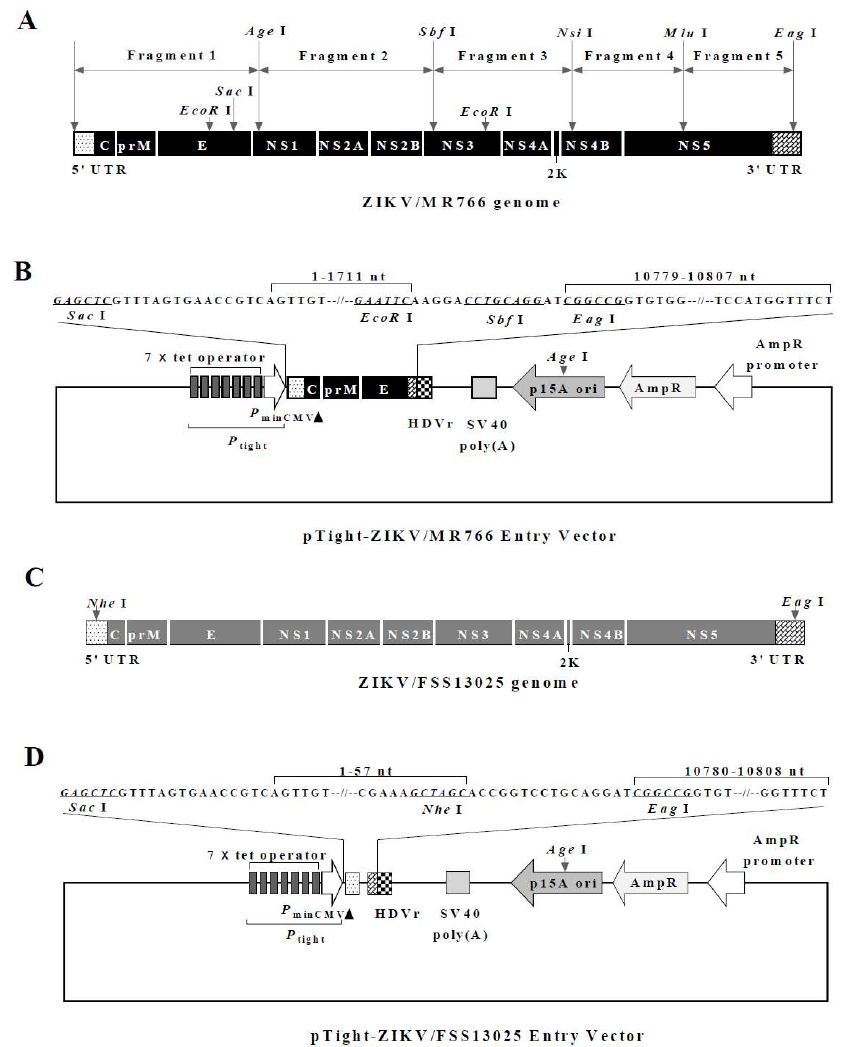
Figure 1. Schematic diagrams of the infectious Zika virus (ZIKV) cDNA amplification and cloning. ( A ) Illustration of subgenomic cDNA amplification and cloning of the African-lineage ZIKV/MR766 strain. Five subgenomic cDNA fragments (1 to 5) of the full-length MR766 genome were initially amplified from its vRNA by reverse transcription polymerase chain reaction (RT-PCR) using specific primers containing unique restriction enzyme sites highlighted in bold on the top. ( B ) Diagram of the pTight-ZIKV/MR766 entry vector. The entry vector was modified from pTRE-Tight by replacing the high-copy-number ColE1 origin of replication with the low-copy-number p15A origin and then inserting the partial MR766 genomic sequence with EcoR I, Sbf I and Eag I sites and hepatitis delta virus (HDV) antigenomic ribozyme sequence at the multiple clone sites region. The rest of the subgenomic cDNA fragments were sequentially inserted into the pTight-ZIKV/MR766 entry vector through the unique enzyme sites, resulting in an infectious MR766 cDNA clone designated pTight-ZIKV/MR766. ( C ) Diagram of the FSS13025 ZIKV genome organization. Two unique restriction enzyme sites Nhe I and Eag I at the 5′ and 3′ ends are highlighted in bold on the top. ( D ) Schematic map of the pTight-ZIKV/FSS13025 entry vector. A DNA fragment containing the 3′ end 21 nucleotides of the minimal CMV promoter, the 5′ end 57 nucleotides and the 3′ end 29 nucleotides of